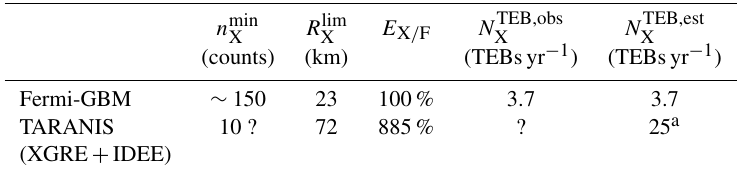
Figure 4. Estimated global detectable TGF density map, and ground tracks of the orbits of TARANIS (planned), RHESSI, Fermi and AGILE. The grey area denotes an approximative South Atlantic anomaly assumed for the simulations, and where TGF can occur but no detection by satellites is possible due to high background. Table 3. Count thresholds, limit radii, detection efficiencies and number of TEBs per year (observed and estimated) for the considered